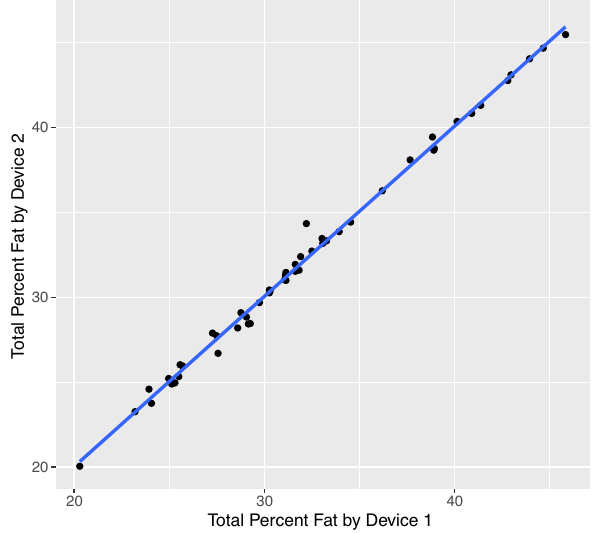
Figure 1. Correlation between mean percent body fat measurements obtained using two bioimpedance devices. Scatter plot with best fit line (solid blue) of percent body fat measurements taken using two different Omron